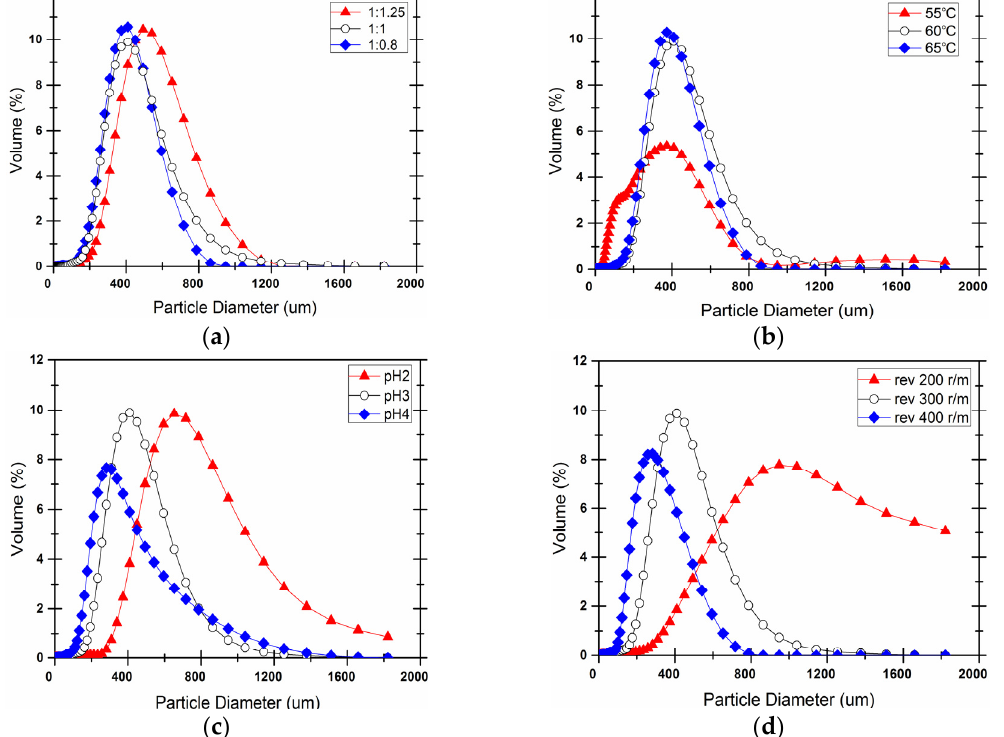
Figure 8. Effect of ( a ) core ‐ wall ratio, ( b ) reaction temperature, ( c ) pH value and ( d ) stirring rate on the microcapsule size distribution.